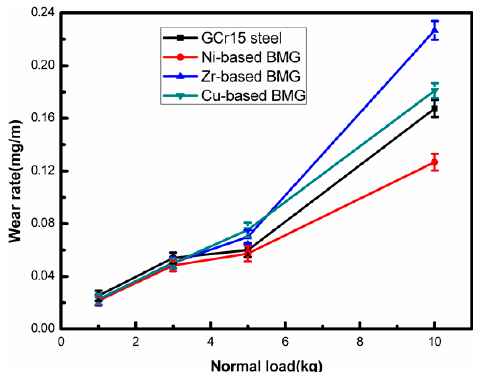
Figure 2. Wear loss of brass plates as a function of normal load for GCr15 steel, Ni-based, Zr-based, Cu-based BMGs at a sliding speed of 5 mm/s and a sliding time of 100 min.